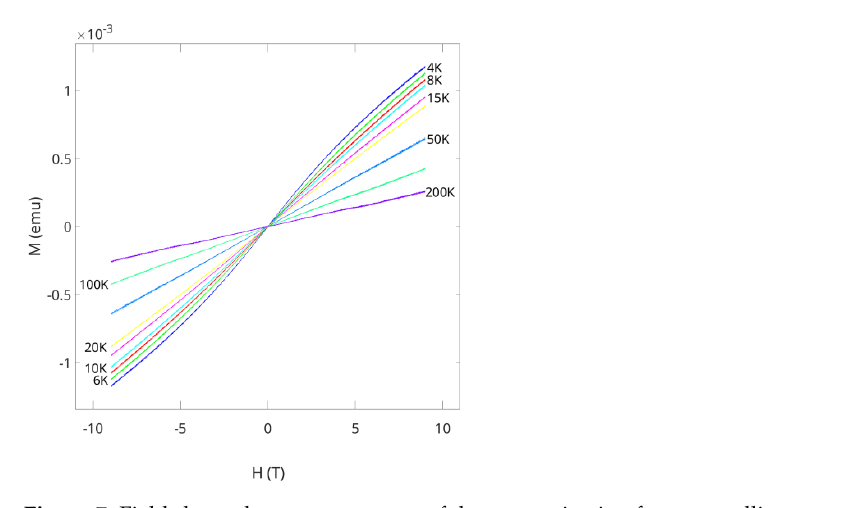
Figure 8. 57 Fe-Mössbauer spectrum of a microcrystalline sample of complex 4 . 2.4. Electrochemistry A cyclic voltammogram of compounds 1 and 2 is given in Figure 9 and clearly shows the singular reversible redox-potential for the Fe 2+/3+ state at E 1/2 = 0.06 V for 1 and E 1/2 = 0.16 V for 2 . As long as an inert atmosphere is ensured, the redox cycle is fully sta- ble. The cyclic voltammogram for the [Fe 4 O 4 ]-cluster 3 shows four different redox poten- tials (Figure 10a), which correlate to the one-electron transitions of the four individual iron atoms each. The first three transitions describe chemically reversible processes, whereas the fourth was found to be only partially reversible.